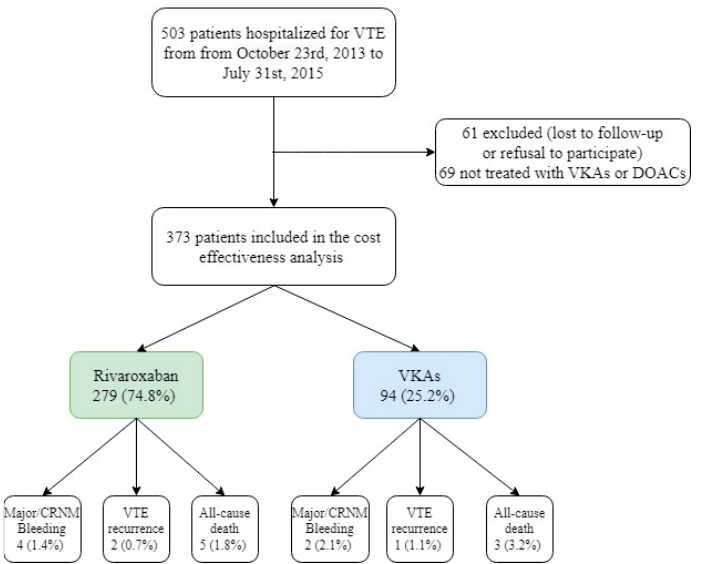
Figure 1. Study flowchart showing eligible patients’ selection. CRNM: clinically relevant non-major; DOACs: direct oral anticoagulants; VKAs: vitamin K antagonists; VTE: venous thromboembolism. The majority of patients ( n = 279) were treated with rivaroxaban at hospital discharge, while VKAs were prescribed for 94 patients (63.1 ± 17.9 versus 71.3 ± 16.6 years old, p < 0.001). In the base-case population, stroke, arterial hypertension and chronic kidney disease were less frequent in the rivaroxaban group compared with the VKAs